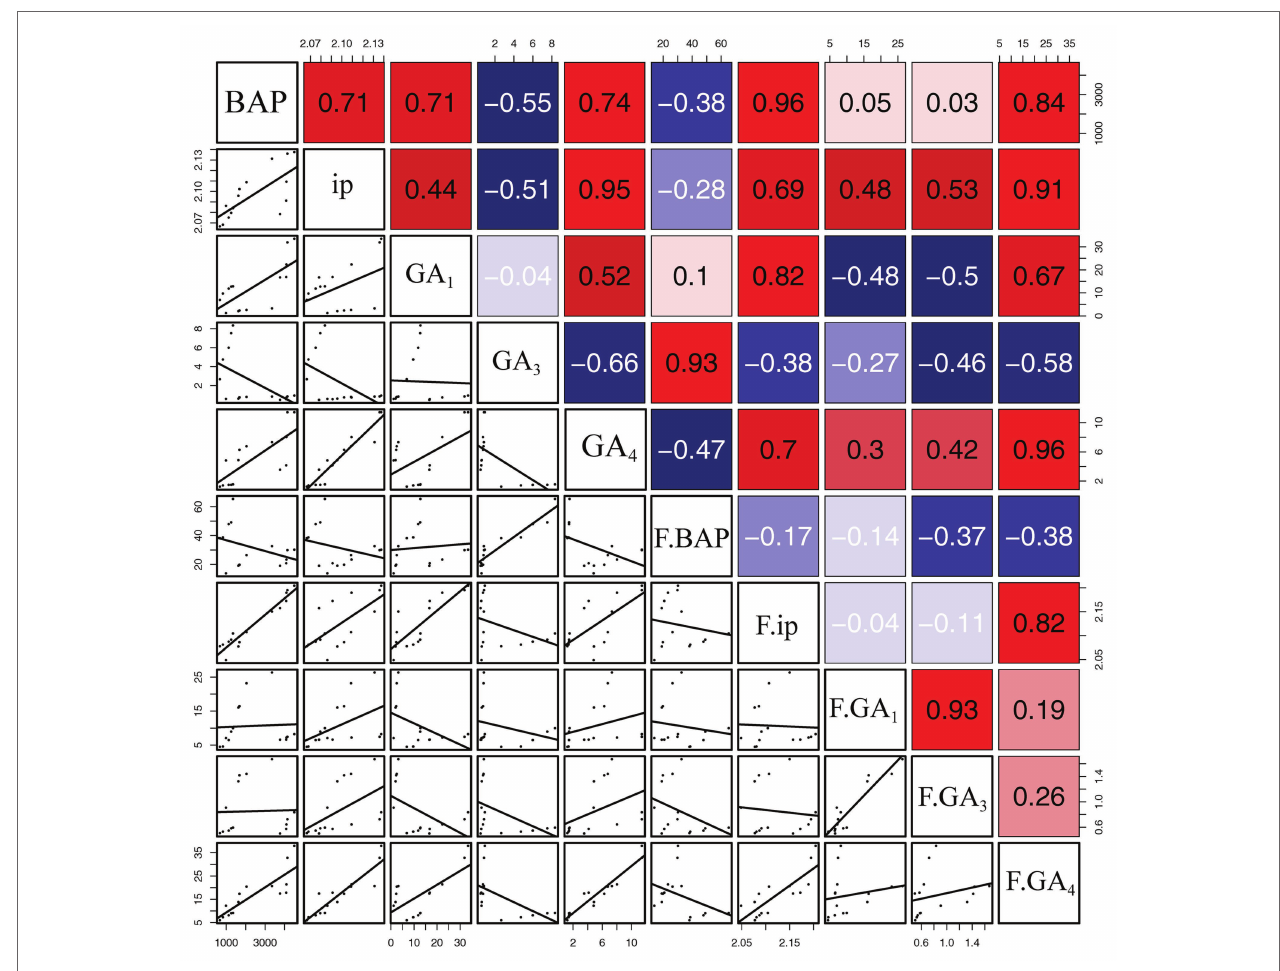
FIGURE 5 | Correlation of growth-related phytohormones between gall tissues and cones. The mean differences were compared using t -test ( p < 0.05). BAP, iP, GA 1 , GA 3 , and GA 4 represent phytohormone levels in gall tissues; F.BAP, F.iP, F.GA 1 , F.GA 3 , and F.GA 4 represent phytohormone levels in cones. Red and blue squares represent positive and negative correlations,